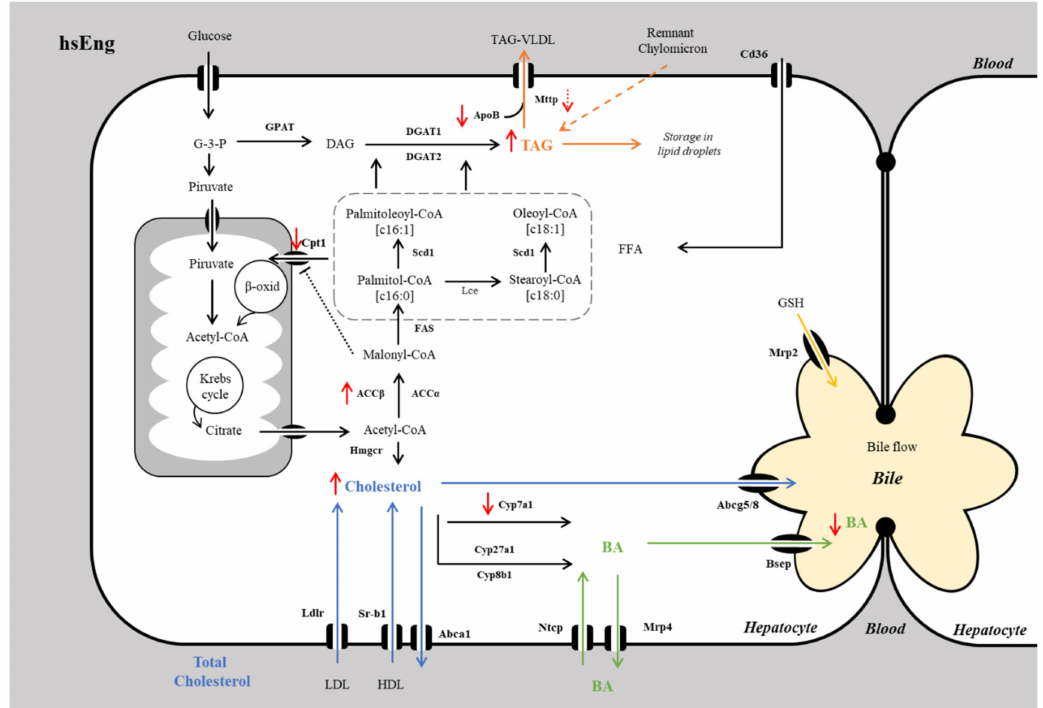
Figure 8. Schematic representation of hsEng e ff ects in lipid, cholesterol, and BA metabolic pathways in the NASH diet-induced mouse model. Increased hepatic TAG content may result from decreased beta-oxidation of fatty acids (via Accb and Cpt1) and its reduced e ffl ux to plasma (by Apob and Mttp). Reduced conversion of cholesterol into BA (via Cyp7a1) may be the reason for increased cholesterol accumulation and consequent lower biliary elimination of BA in a NASH liver. Full red arrow—statistically significant. Dotted red arrow—borderline significance. Blue arrows—circulation of cholesterol. Green arrows—circulation of bile acids. Yellow arrow—e ffl ux of glutathione. Orange arrows—circulation of TAG. Black arrows metabolic pathways. Abca1, ATP-binding cassette transporter; Abcg5 / 8, Dimer of ATP-binding cassette subfamily G member 5 and member 8; ACC, acetyl-CoA carboxylase; Apob, Apolipoprotein B; β -oxid, beta-oxidation; BA, bile acids; Bsep, Bile salt export pump; Cd36, cluster of di ff erentiation 36; DAG, Diacylglycerol; DGAT, Diglyceride acyltransferase; FAS, Fatty acid synthase; FFA, free fatty acids; G-3-P, Glyceraldehyde-3-phosphate; GPAT, Glycerol-3-phosphate acyltransferase; GSH, Glutathione; HDL, high-density lipoproteins; Hmgcr, 3-Hydroxy-3-methylglutaryl-CoA reductase; hsEng, Human soluble endoglin; Lce, long chain fatty acyl elongase; LDL, low-density lipoproteins; Ldlr, LDL receptor; Mrp2, Multidrug resistance-associated protein 2; Mrp4, Multidrug resistance-associated protein 4; Mttp, Microsomal triglyceride transfer protein; Ntcp, sodium / taurocholate cotransport polypeptide; Scd1, Stearoyl-CoA desaturase-1; Sr-b1, Scavenger receptor class B type 1; TAG,